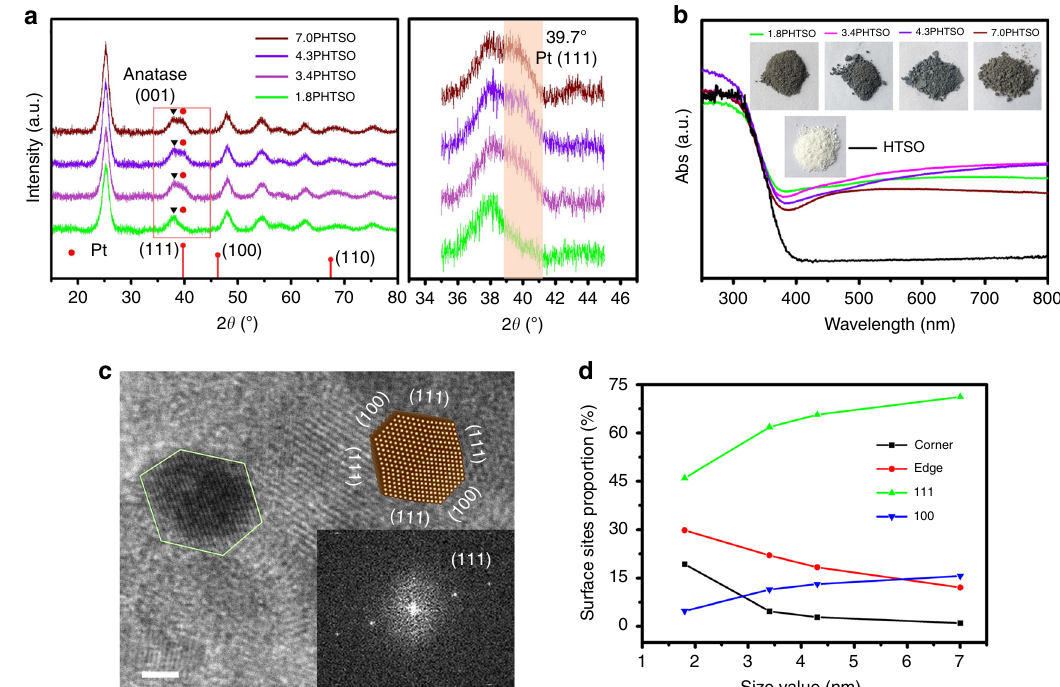
Fig. 2 Crystallinity, surface morphology and optical properties of x PHTSO. a XRD patterns and the inset image show the local magni fi cation from 2 θ at the 35 – 45° range. b UV – Vis DRS spectra and the corresponding samples ’ photos (inset). c HR-TEM image of 7.0PHTSO, the scale bar is 2 nm; the inset image with the marked facets of Pt NPs shows the characteristic truncated-octahedron shape of this Pt particle; the inset image of the corresponding fast Fourier transform (FFT) pattern of the Pt particle. d Proportions of the corner, edge, Pt (111) and Pt (100) surface sites based on the standard truncated octahedron model of Pt NPs with different